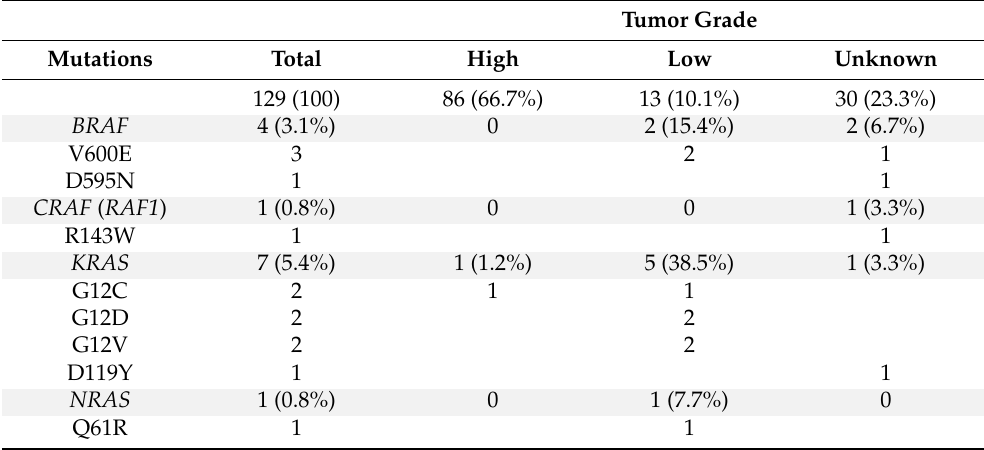
Tumor Grade Tumor Grade